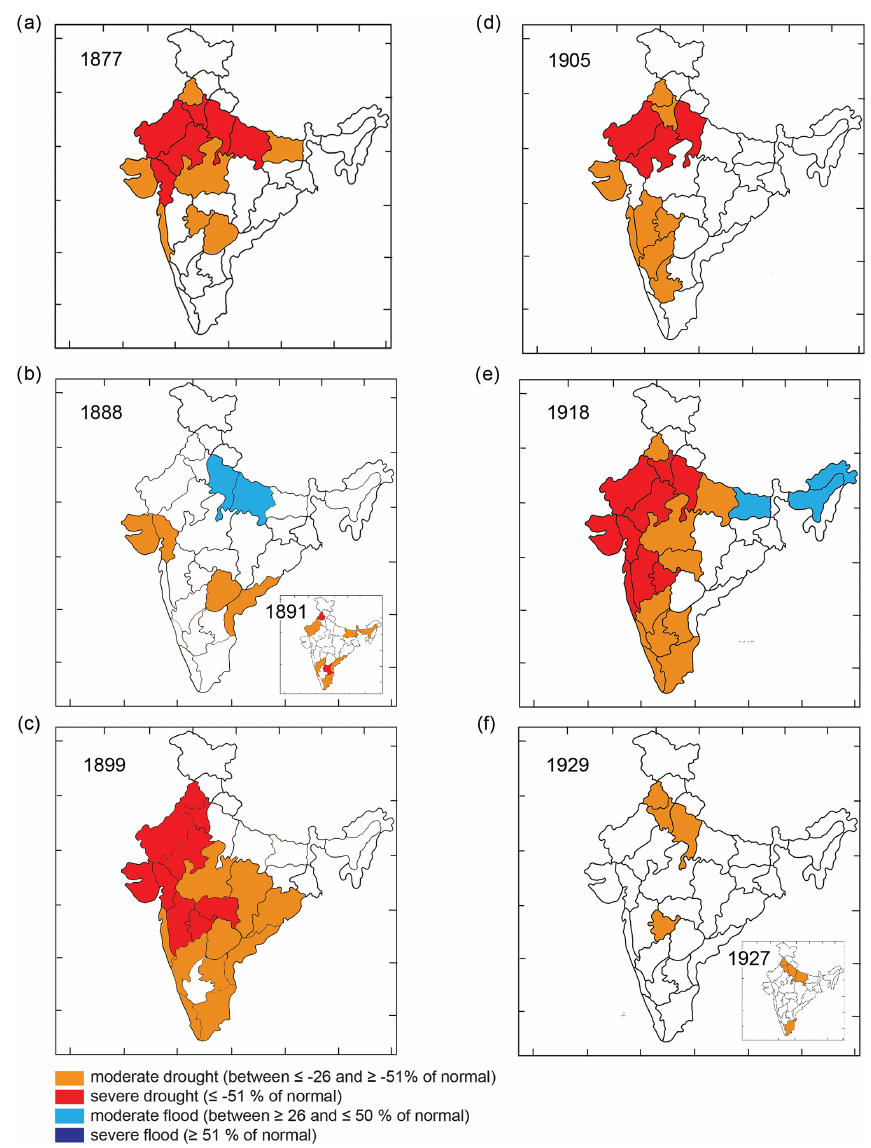
Figure 7. The distribution of meteorological subdivisions in NW India reporting drought during periods of high spectral intensity at a = 27